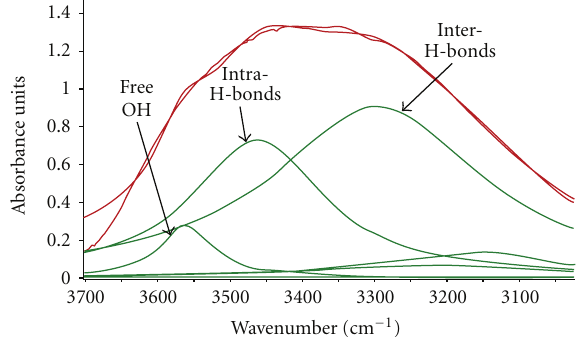
Figure 3: Curve fitting and peak assignments for OH stretching regions: S4: untreated wood fibre.